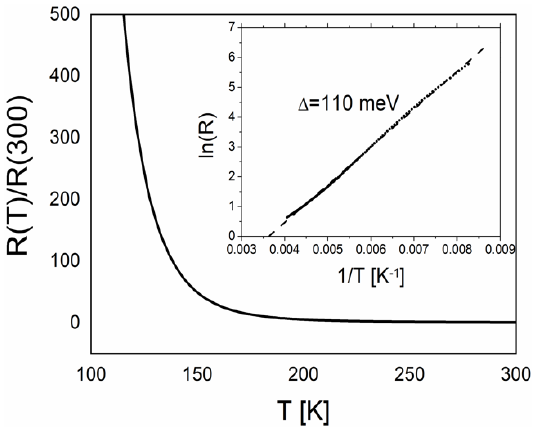
Figure 12. The temperature and pressure dependence of the resistance of the pseudo- κ″ -(BDH-TTP) 3 (ReO 4 ) 2 ( 3 ) salt measured in the conducting ab plane.